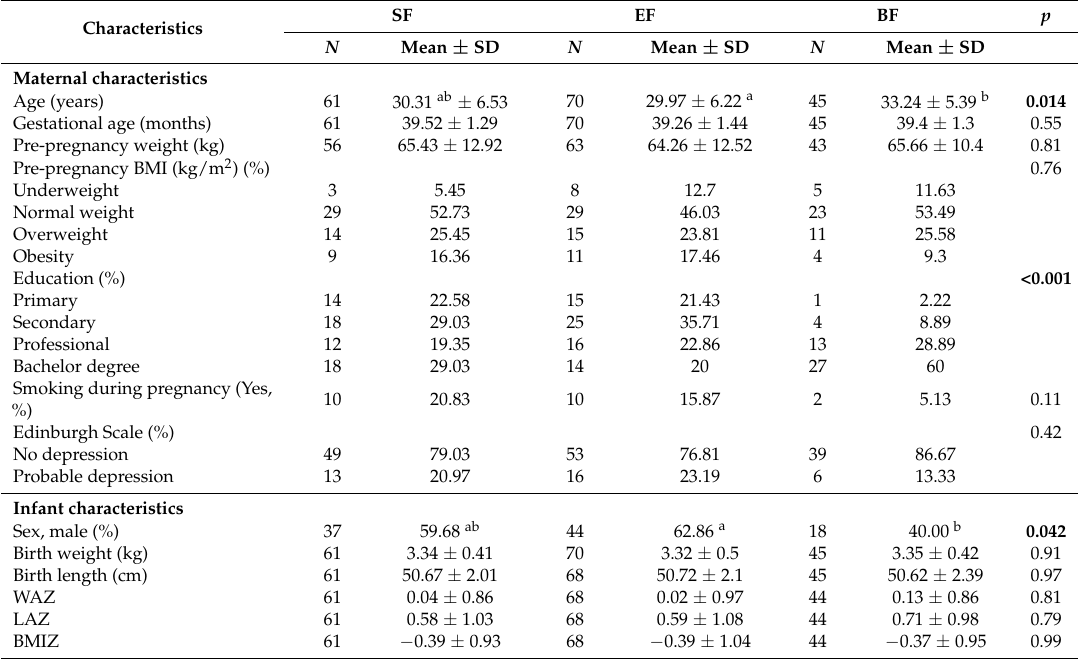
Table 2. Characteristics of the